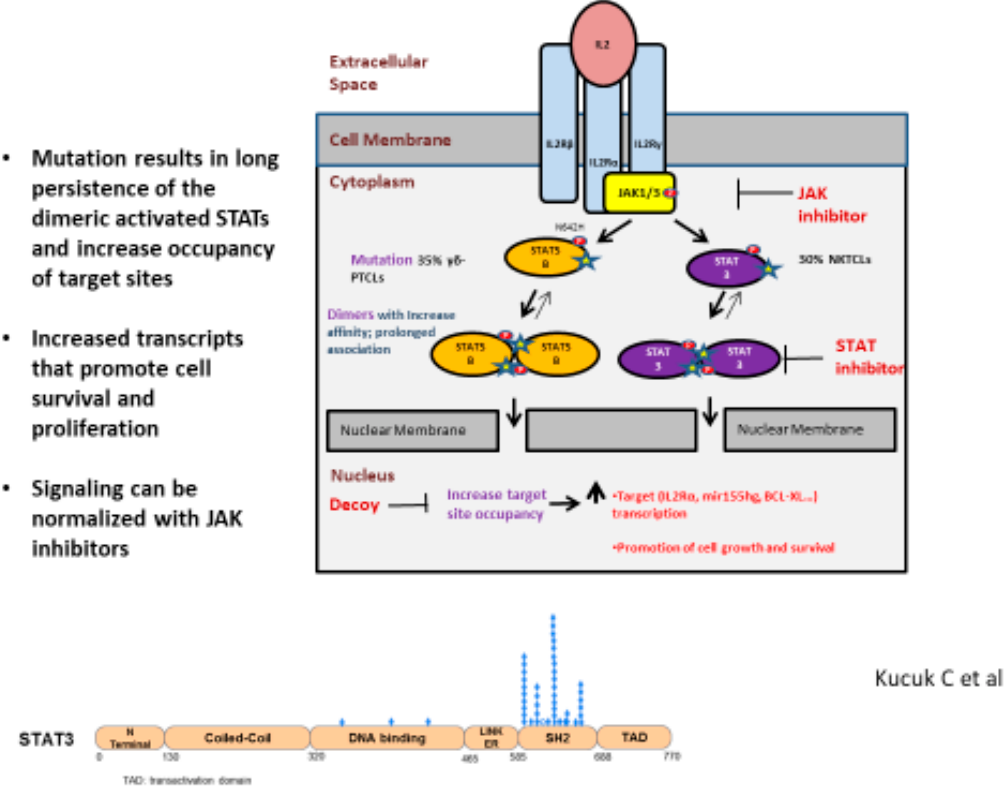
Figure 2. Biological effects of SH2 domain mutations in STAT3 and STAT5B (modified from Kucuk C et al. Nat Commun 2015 [186]).